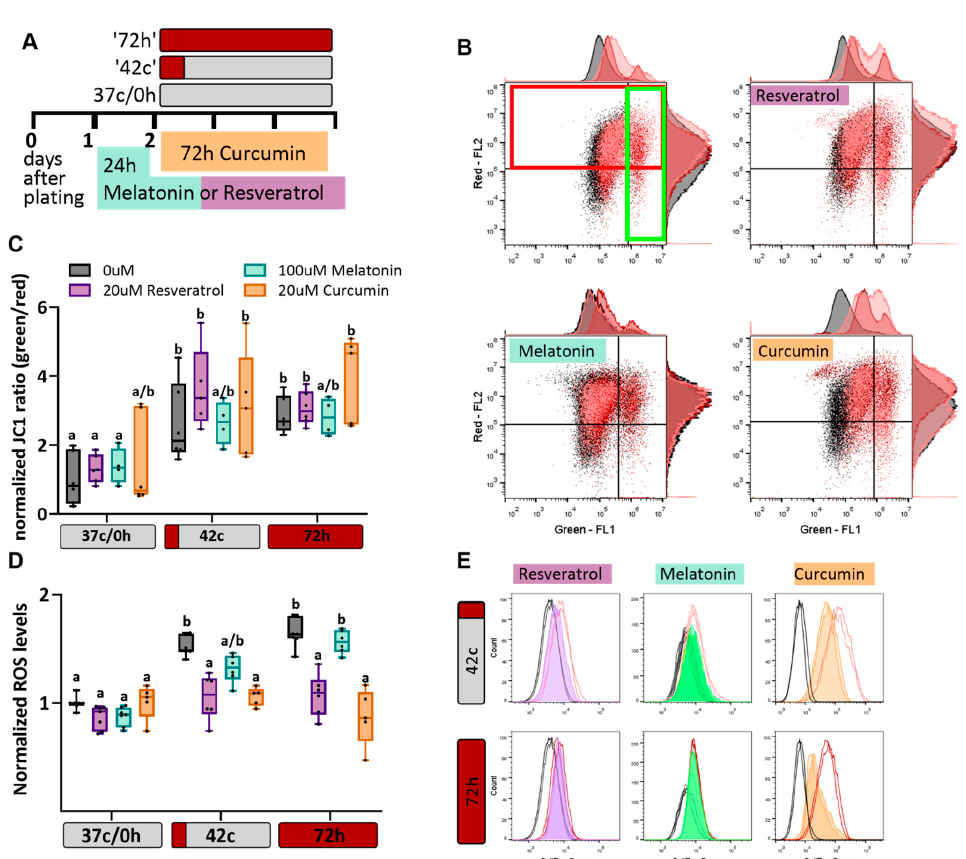
Figure 2. The effect of antioxidants on mitochondria and ROS. ( A ) Schematic illustration of the experimental design: bovine umbilical cord-MSC are plated and 24 h later treated with resveratrol or melatonin. On day 2 the cells are placed at 42 ◦ C for 1 h and then allowed to recover at 37 ◦ C for three days (42 c) or at 40.5 ◦ C for 3 days (72 h). Curcumin is added on day 2 with the heat shock. ( B ) Membrane potential was measured using JC-1 dye and flow cytometry. Representative results are shown. Cells before and after heat shock treatment (black and red dots/histograms, respectively. Bright red indicates 42 ◦ C HS and dark red histogram indicates 72 h HS) are shown with or without antioxidant addition to the growth media. Percent of cells showing mitochondrial depolarization is increased after short and long heat shock as compared to the untreated cells. ( C ) Summary of six biological repeats. Two-way ANOVA with FDR rates calculated using two-stage linear step-up procedure of Benjamini, Krieger and Yekutieli was used for statistical analysis, different letters indicate significant differences ( p < 0.05), where two letters appear-significant difference was observed from neither sample. ( D ) Flow cytometry results of CellROX staining for cellular ROS levels after heat shock, treated with the three antioxidants. Data presented are a mean of green fluorescence as compared to 37 ◦ C, 0 h, n = 6. Two-way ANOVA with FDR rates calculated using two-stage linear step-up procedure of Benjamini, Krieger and Yekutieli was used for statistical analysis, different letters indicate significant differences ( p < 0.05), as in ( C ). ( E ) An example from the data summarized in ( D